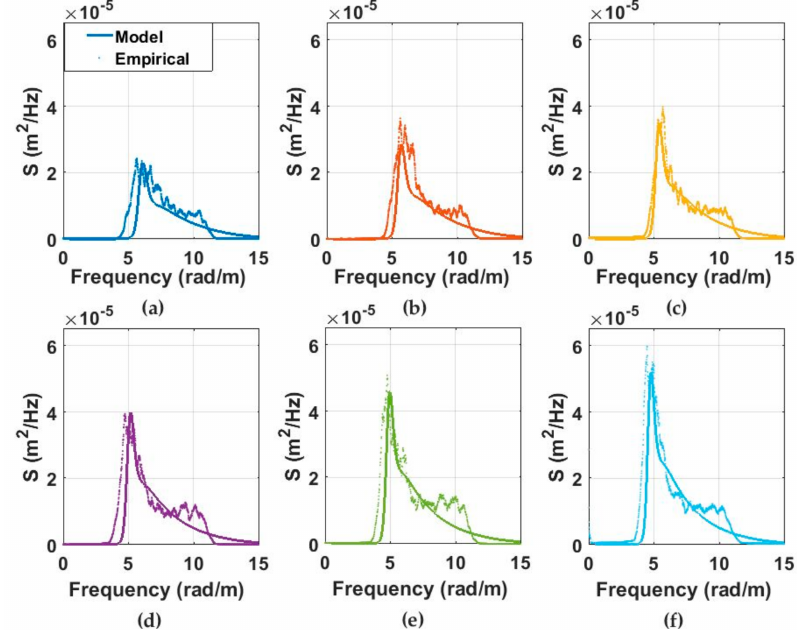
Figure 7. Experimental wave spectrum matched to fully developed capillary-gravity Apel wave spectrum model. Distance from the fan: ( a ) 3.5 m; ( b ) 4.5 m; ( c ) 5.5 m; ( d ) 6.5 m; ( e ) 7.5 m and ( f ) 8.5